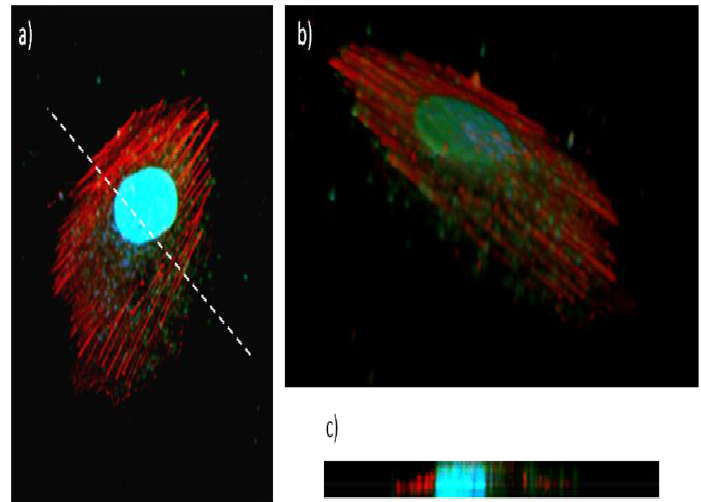
Figure 7. Uptake of Gel/CdS QDs (green) by HUVEC exposed for 24 h at 5 µg/mL, after which the cells were stained for actin (red) and subjected to nuclear counterstaining (blue), ( a ) shows a confocal slice in the middle of the cell (slice 7) revealing high levels of QDs within the cellular environment, between the actin fibers, ( b ) shows a 3D view of a labelled cell, consisting of a composition of 15 slices with 0.24 µm interslice distance, ( c ) shows a projection along the Z-axis of the 3D figure, taken along the line drawn in ( a ). These data reveal high levels of Gel/CdS QDs internalized by the cells.